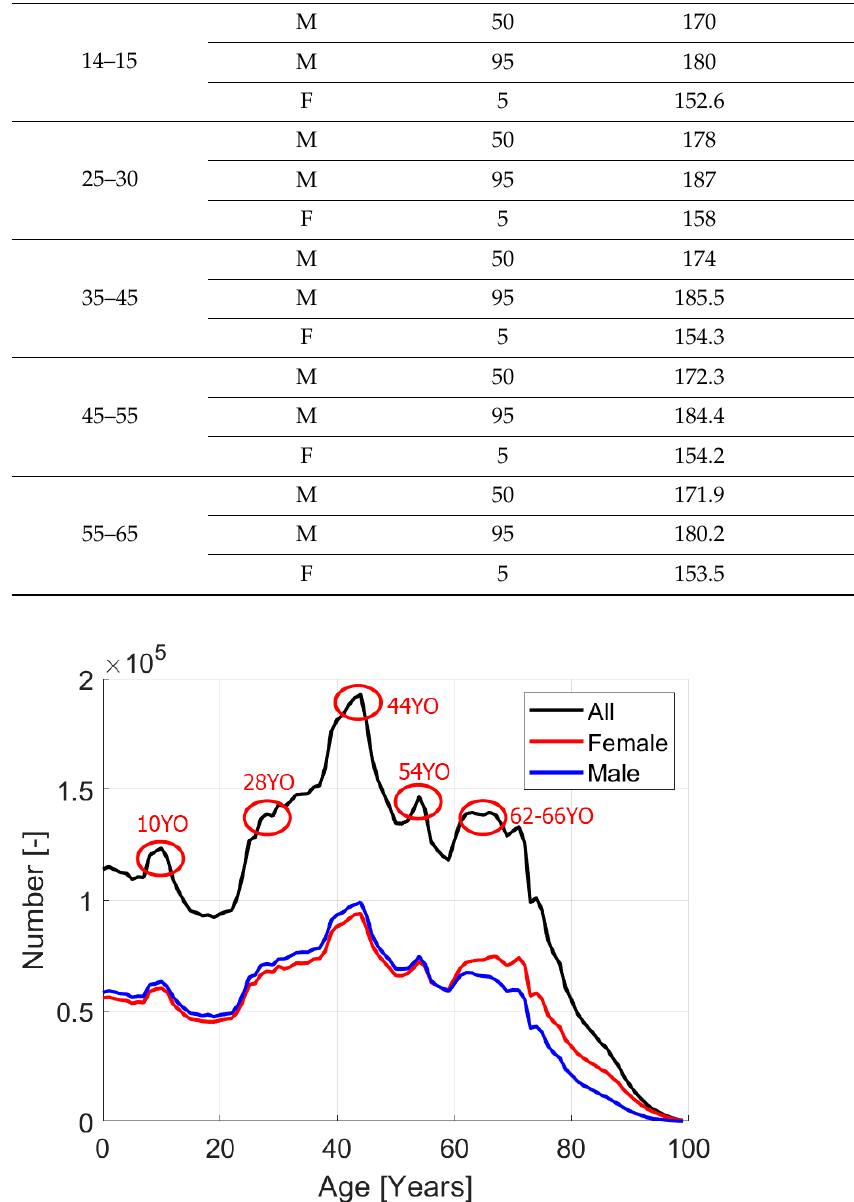
Figure 1. Population of the Czech Republic in 2019 (source: Czech Statistical Office).